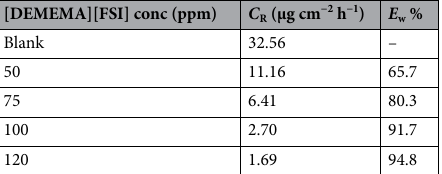
[DEMEMA][FSI] conc